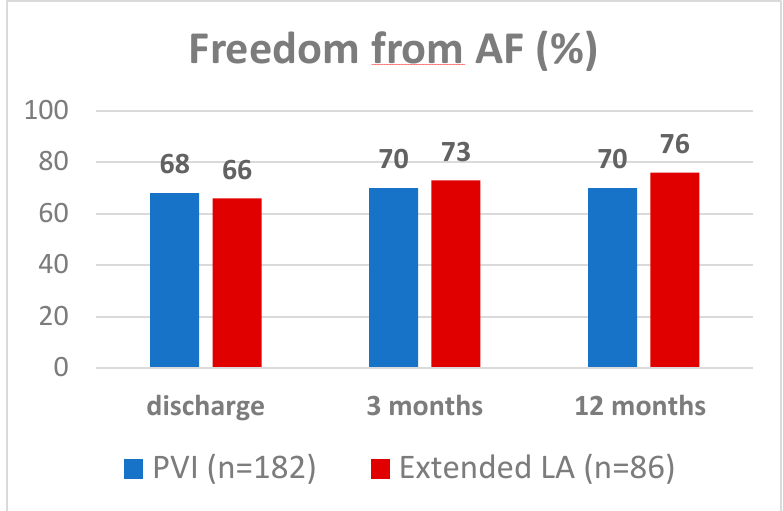
Figure 1. Rate of freedom from AF during follow up.